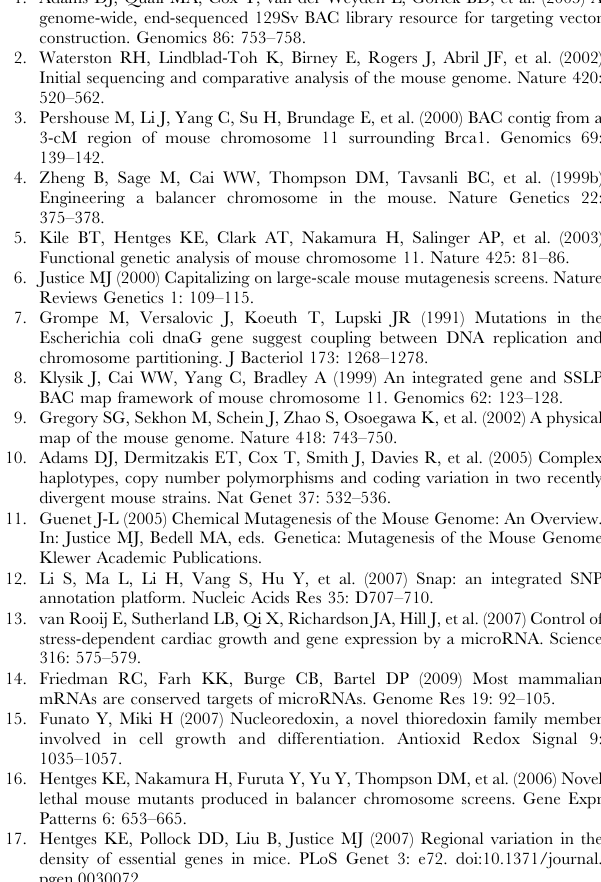
Table S6 Known genes associated with mutant alleles that lie in the Trp53-Wnt3 interval.